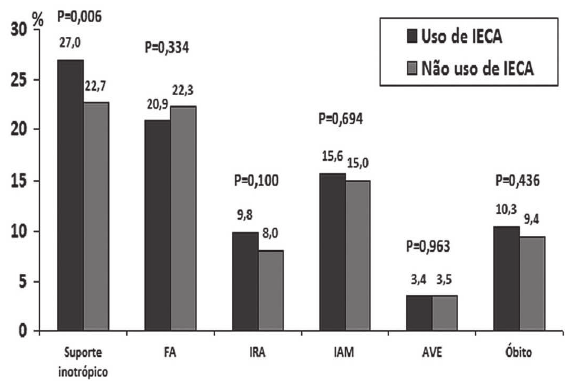
Fig. 1 - Desfechos clínicos bo pós-operatório de cirurgia de revascularização do miocárdio em análise univariada por qui- quadrado IECA - inibidor da enzima conversora de angiotensina; FA - fibrilação atrial; IRA - insuficiência renal aguda; IAM - infarto agudo do